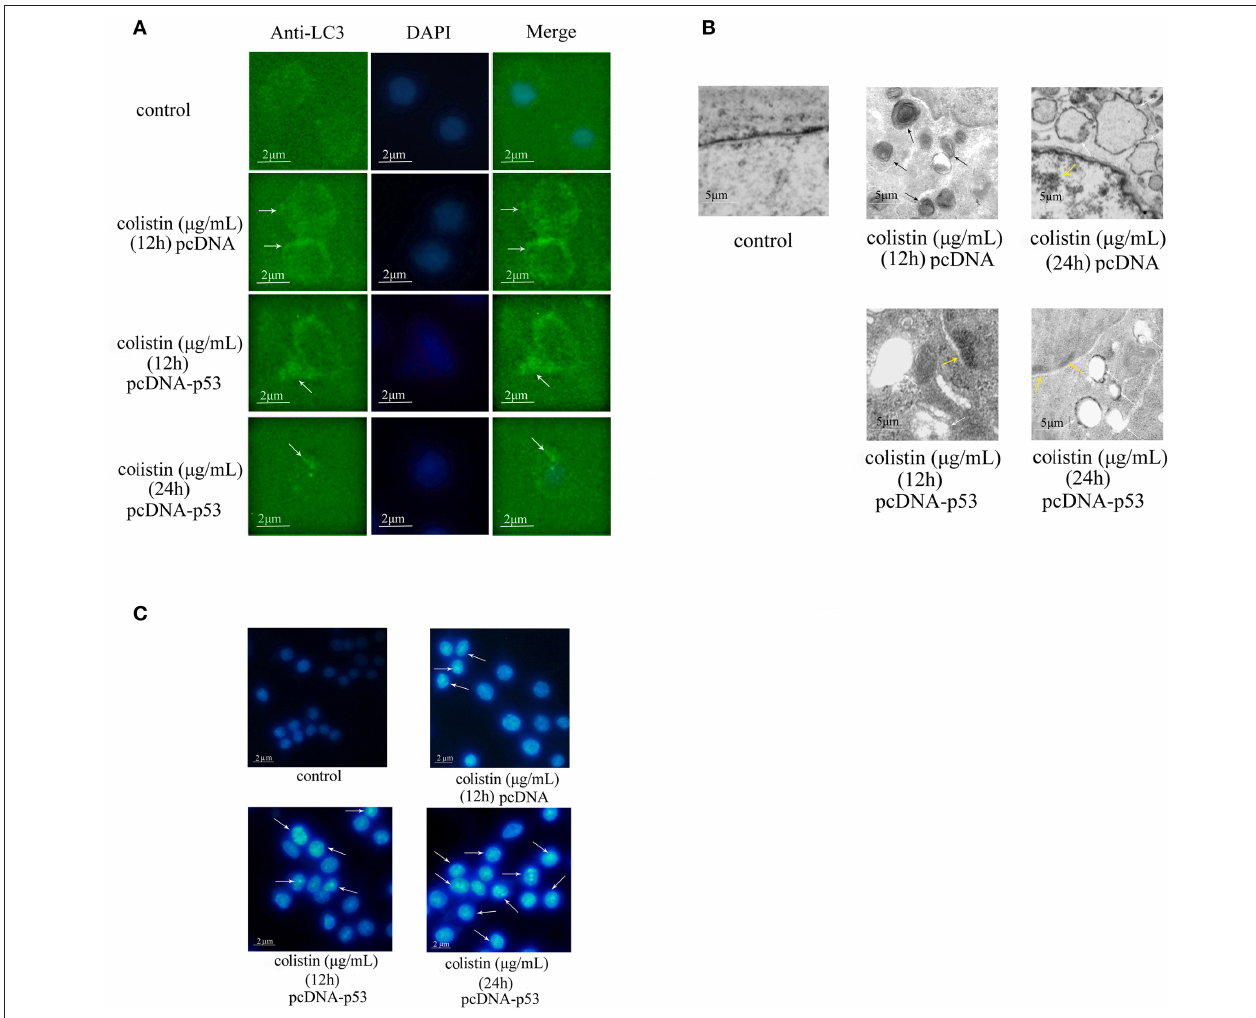
FIGURE 6 | Morphologic analysis of p53-induced autophagy in colistin-treated PC-12-p53 cells. (A) LC3 staining of p53 overexpressing cells following 125 µ g/mL colistin treatment for 12 and 24h. The control group was transfected with null vector. Arrow indicates LC3 punctum. (B) Transmission electron microscopy observations of the control PC-12 cells, PC-12-pcDNA cells treated with colistin at 12 and 24h and PC-12-p53 cells treated with colistion (12 and 24h). Autophagosomes, cytoplasmic vacuolization, and chromatin condensation in the treated groups are marked with black, white, and yellow arrows respectively. (C) Hoechst 33258 staining showed changes in the nuclear morphology of cells treated with colistin for 12 and 24h. Arrows indicate fragmentation of the nuclear or karyopyknosis.